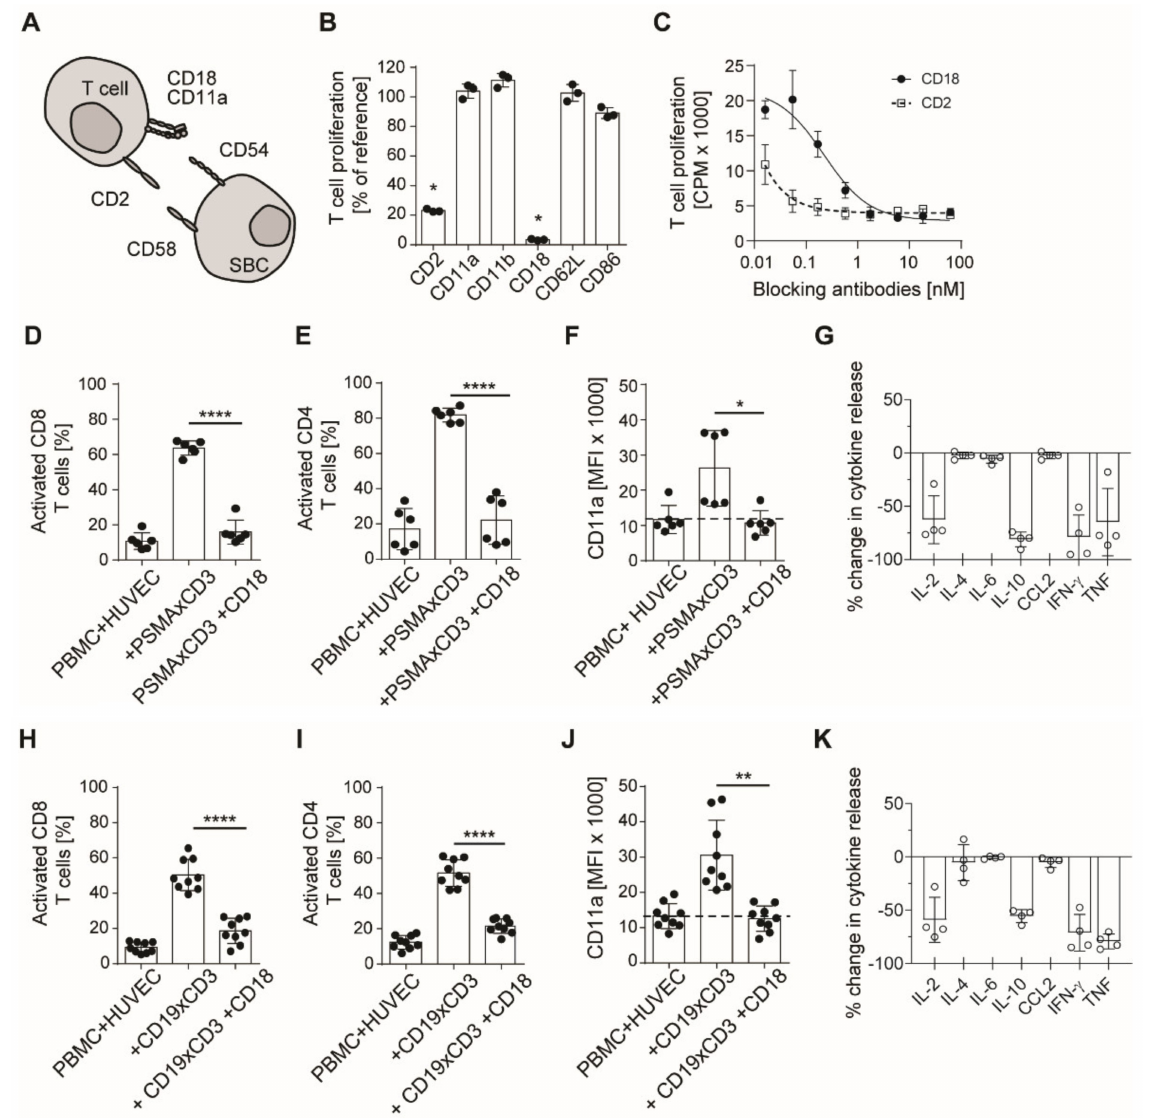
Figure 4. Reduced off-target activation by blockade of adhesion molecules on T cells. ( A ) Schematic illustration of costimulation by interaction of CD2 and CD11a/CD18 with CD58 and CD54, respectively. ( B ) Off-target T cell activation was induced in a 3 day 3H-thymidine incorporation assay ( n = 3, mean ± SD, unpaired t -test) using 100,000 PBMC, 30,000 HUVEC and a PSMAxCD3 antibody at 1 µ g/mL. Addition of different blocking antibodies at 10 µ g/mL directed against costimulatory/adhesion molecules on T cells. ( C ) Inhibition of off-target T cell proliferation by CD18 and CD2 antibodies in a thymidine assay as described in B ( n = 3, mean ± SD). ( D,E ) Flow cytometric analysis of CD69 expression on CD8+ and CD4+ T cells upon off-target stimulation with 30,000 HUVEC and a PSMAxCD3 antibody at 1 µ g/mL ( n = 6, mean ± SD, unpaired t test). ( F ) Flow cytometric analysis of CD11a expression on CD8+ T cells through off-target activation as described in d ( n = 6). ( G ) Cytokine release analyzed by LEGENDplex ( n = 4) during off-target activation induced by PSMAxCD3 antibody utilizing supernatants from assays as described in D , E . ( H , I ) Off-target stimulation of CD19xCD3 in the presence of 30,000 HUVEC, CD19xCD3 antibody at 1 µ g/mL and B cell-depleted PBMC ( n = 6). The blocking CD18 antibody was added at 10 µ g/mL. Analysis of CD69 expression on CD8+ and CD4+ T cells was obtained by flow cytometry. ( J ) Flow cytometric analysis of CD11a expression on CD8+ T cells through off-target activation as described in G ( n = 9). ( K ) Cytokine release analyzed by LEGENDplex ( n = 4) during off-target activation induced by CD19xCD3 antibody utilizing supernatants from assays as described in H-I. * p < 0.05, ** p < 0.01, **** p <